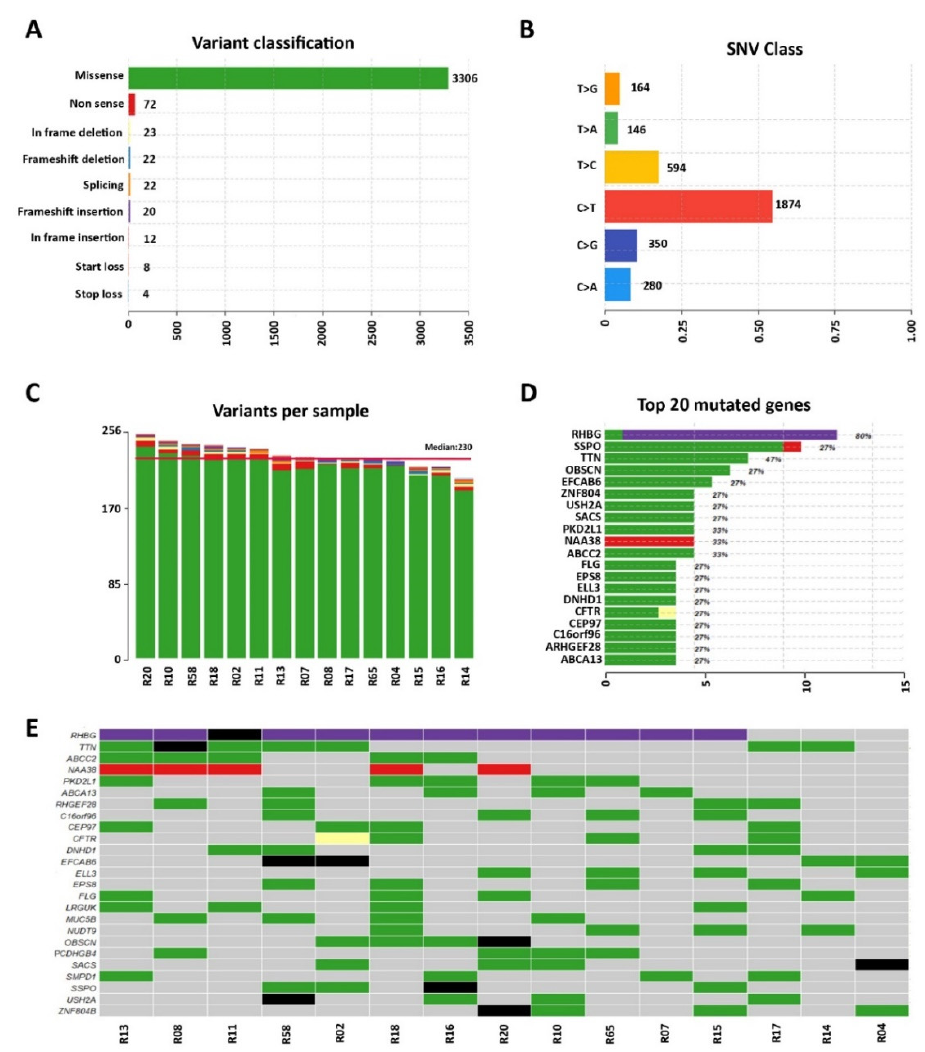
Figure 1. Summary of variants identified in 15 DCM patients. ( A ) The number of variants is subdivided by Human Genome Variation Society (HGVS) classification criteria. ( B ) Single Nucleotide Variant (SNV) classes. ( C ) The number of variants identified per sample. ( D ) Top 20 most frequently mutated genes across the cohort. The percentage on top of the bar represents the number of mutated samples and the bar color indicates the variant type. ( E ) Plot generated by Maftools with the details of mutations found in each patient in the top 25 mutated genes sorted and ordered by decreasing frequency. The different variant types are defined by colored boxes: green for missense variants; purple for a frame-shift variant; yellow for in-frame variants; red for non-sense variants; and black for multiple variants detected in a specific gene.